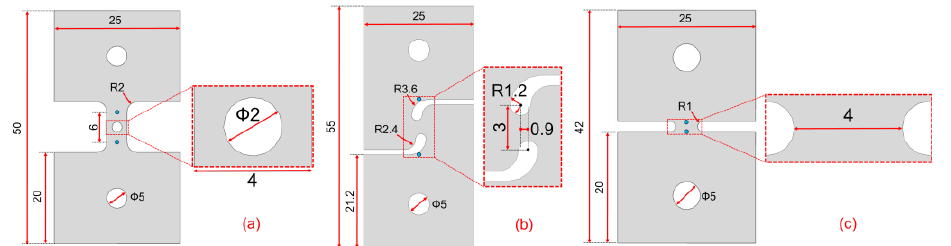
Fig. 2. Specimen geometries: (a) Central hole (b) Shear (c) Plane